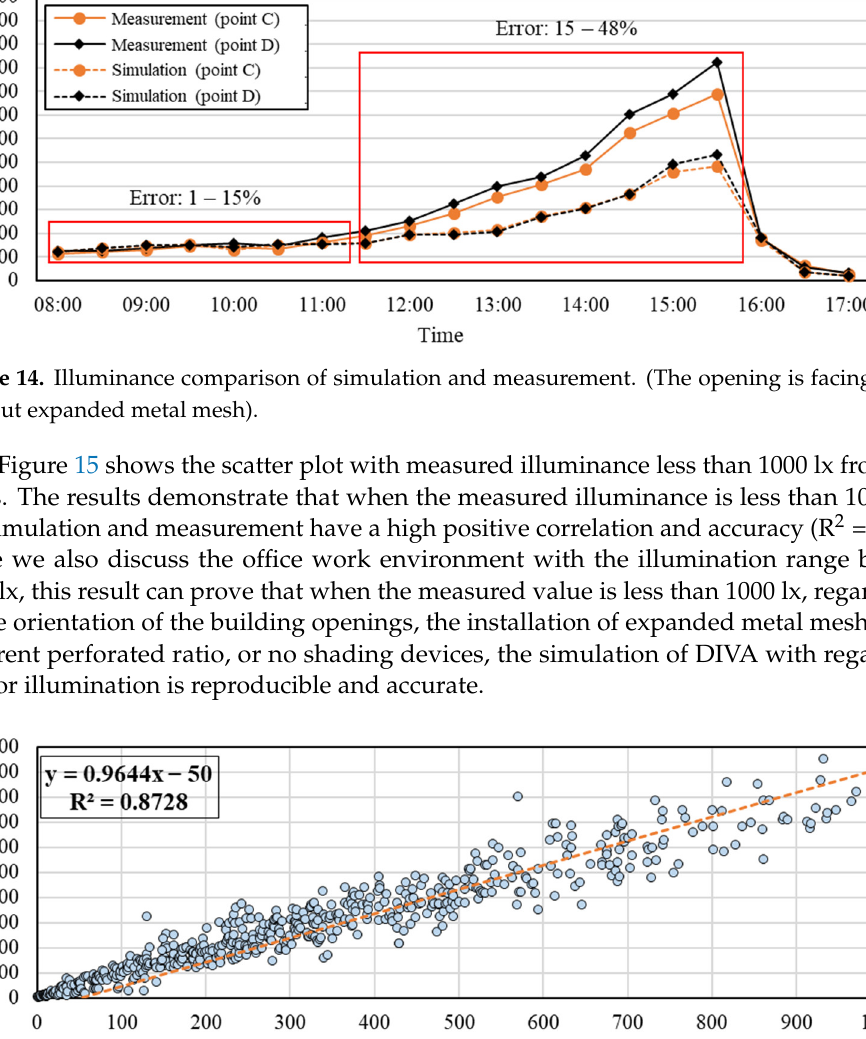
Table 10. Lighting and energy consumption result table of each simulated case.